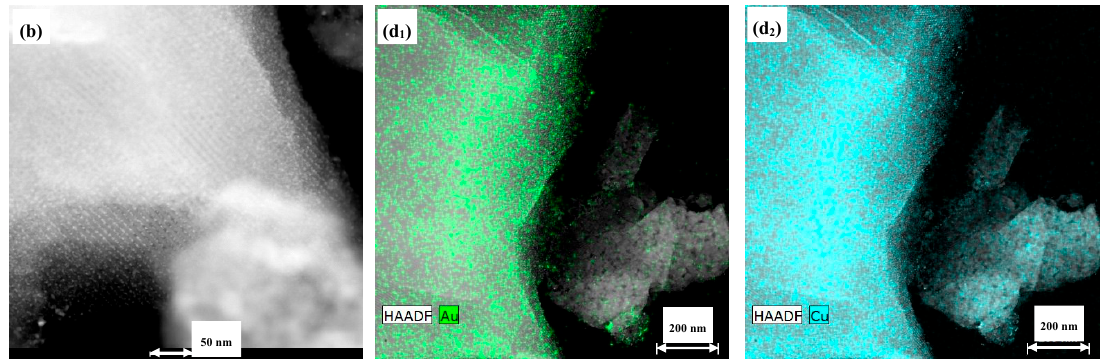
Figure 8. ( a i ) TEM, ( b ) STEM, ( c ) particle size distribution and ( d i ) mapping results for Au-Cu/Ti-SBA sample.